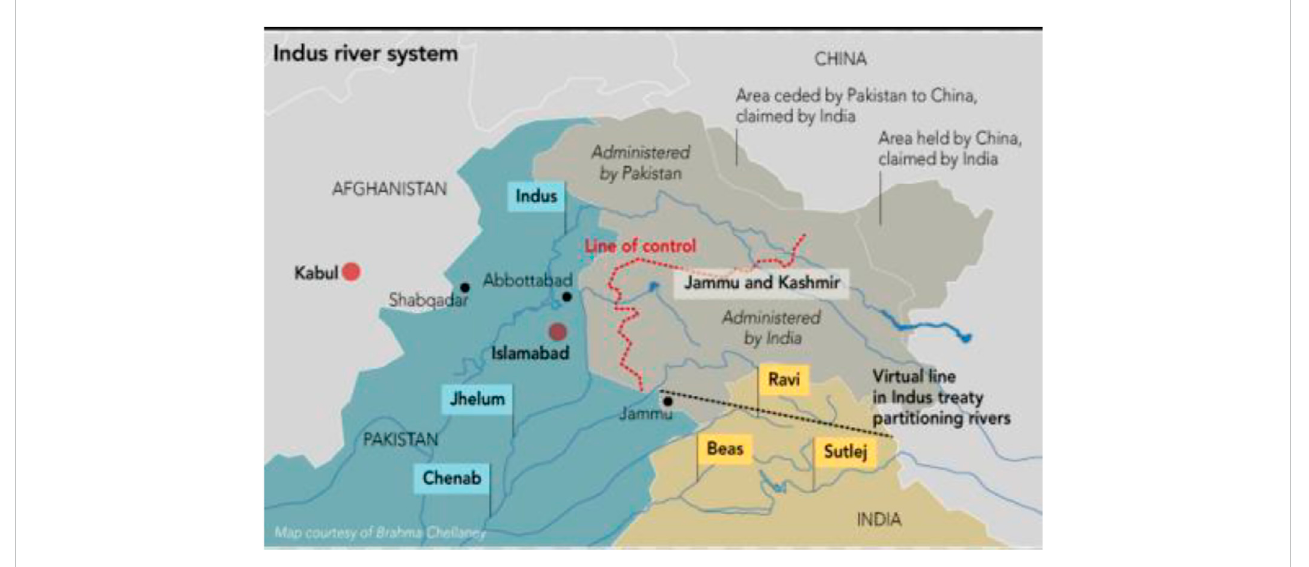
FIGURE 10 Indus water treaty and distribution of rivers between India and Pakistan.